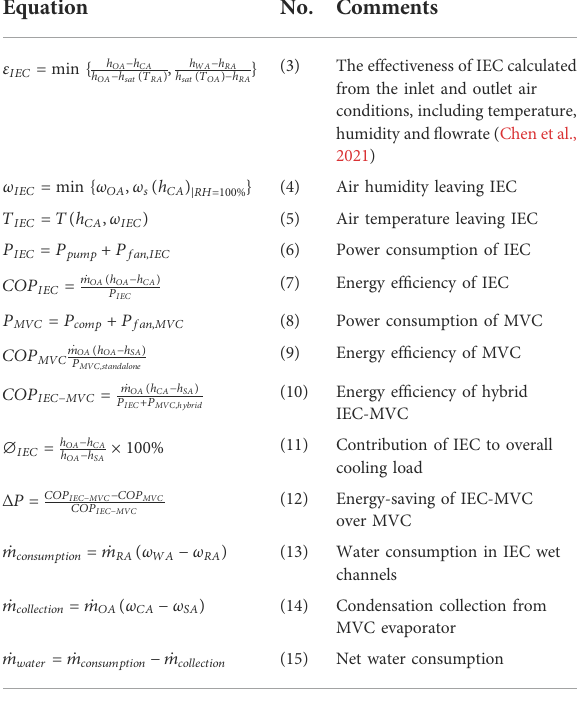
TABLE 1 Correlations for evaluating the IEC-MVC cycle. Equation